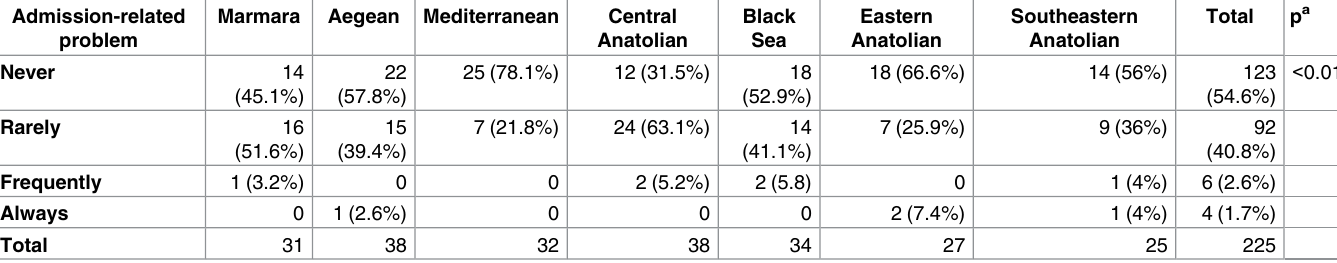
Table 2. Frequency of problems related to patient admission by geographical